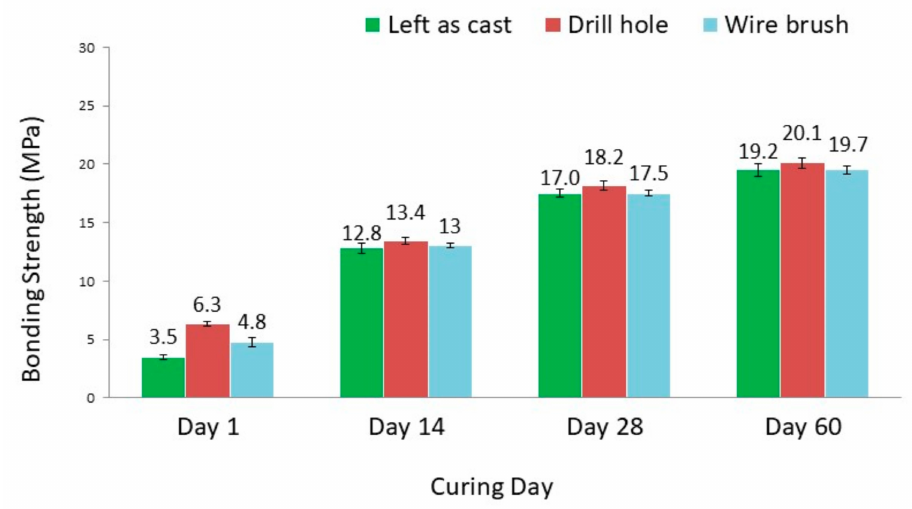
Figure 7. Bonding strengths of geopolymer repair materials (GRMs) with different surface preparations of the